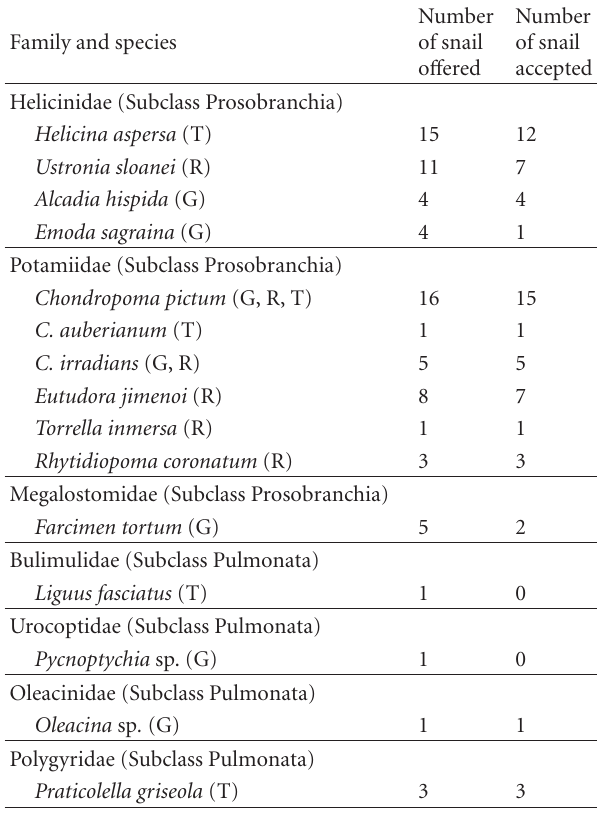
Table 1: List of snail species o ff ered to Alecton discoidalis larvae. The most common substrate of each species is indicated, G: ground dwelling. R: rock dwelling. T: tree